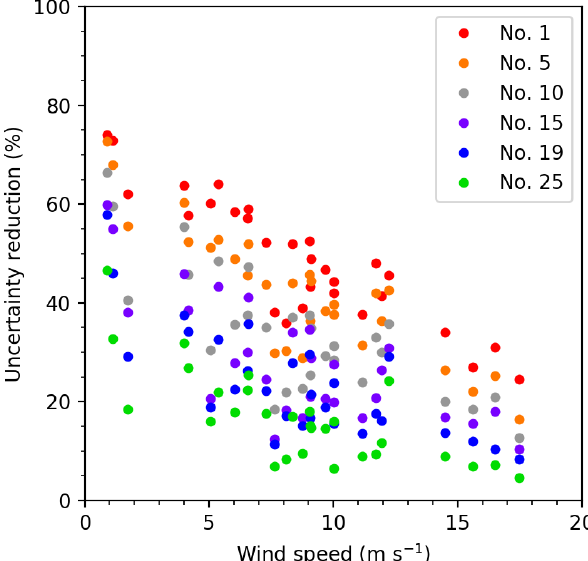
Figure 1. Theoretical uncertainty reduction for the 6h mean emis- sions in the PMIF-Paris experiments using the 1st (red), 5th (or- ange), 10th (light green), 15th (purple), 19th (blue) and 25th (green) best observation sampling from the CarbonSat simulation. The re- sults from the 31 inversion days are given as a function of the aver- age wind speed over the Paris clump. A comparison with the results from Broquet et al. (2018) is given in Fig.